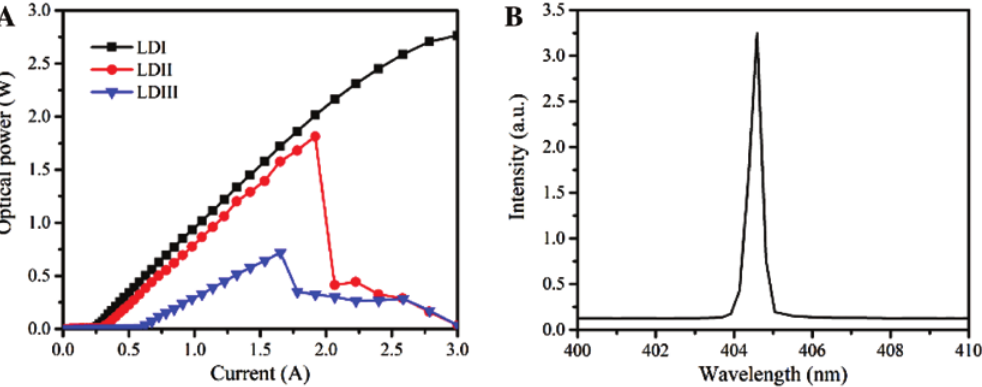
Figure 4: (A) Shows the optical power of 3 prepared GaN-based blue-violet LD devices as a function of the forward direct-current and (B) gives the optical spectrum of stimulated emission. The threshold current of LDI, LDII and LDIII is around 220.0 mA, 298.1 mA and 555.2 mA, respectively, and the peak optical power of LDI, LDII and LDIII is about 2.77 W, 1.81 W and 0.72 W, respectively. (A) Optical power vs. current ( P - I ) curves of the LDI (black). LDII (red) and LDIII (blue), and (B) The optical spectrum of stimulated emission measured at room temperature.